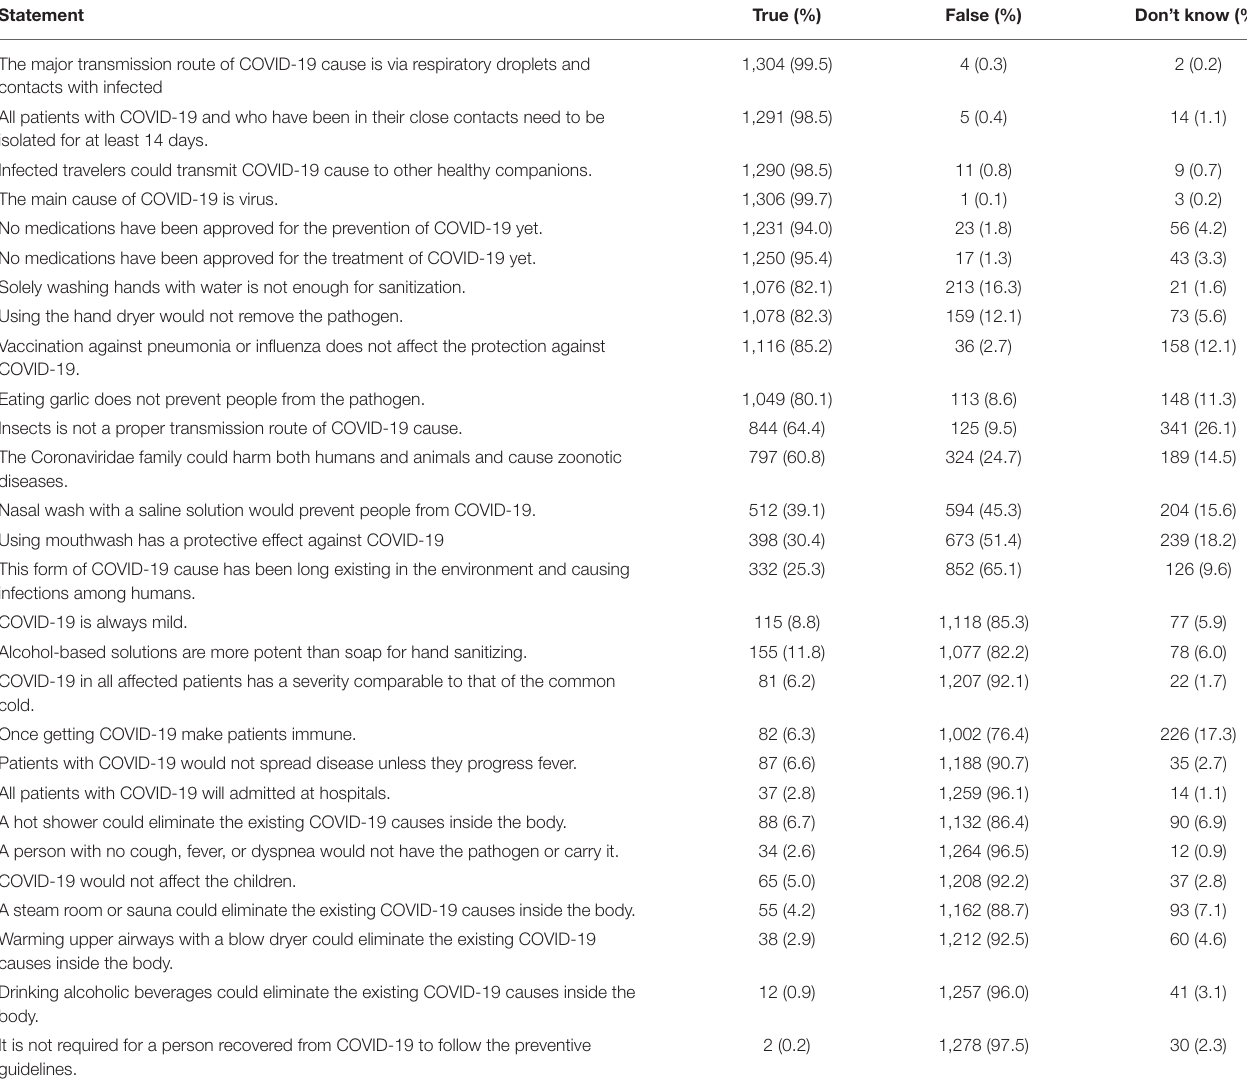
TABLE 5 | Frequency of participants’ answers to questions about general knowledge about COVID-19.